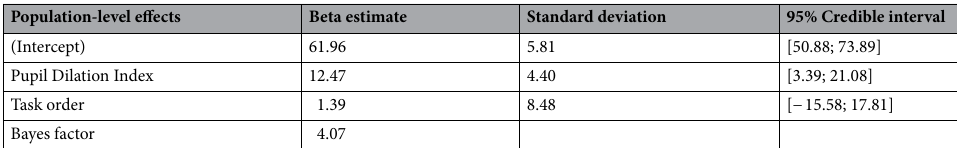
Table 2. Dietary health challenge success by Pupil Dilation Index and task order. Dietary health challenge success modelled with a Bayesian linear regression as a function of Pupil Dilation Index and task order (Eq. 4): the individual dietary health challenge success level (measured over all challenging trials in percentage points) is explained by the standardized and mean-centred Pupil Dilation Index (PDI). Compared to the average level of PDI in the group, an increase of 1 standard deviation (SD) in pupil dilation explains an additional 12.47% of dietary health challenge success on top of the 61.96% health challenge success that an individual with average PDI would show. The analysis is controlling for a factor representing Task Order (emotion regulation or dietary choice task first). Task order does not explain variation in dietary health challenge success levels (95% credible interval for the estimate includes zero). Model fits are given as the population level mean of the posterior distribution ± standard deviation (SD) and the 95% credible interval. The Bayes factor is given for a comparison of the model against an intercept-only